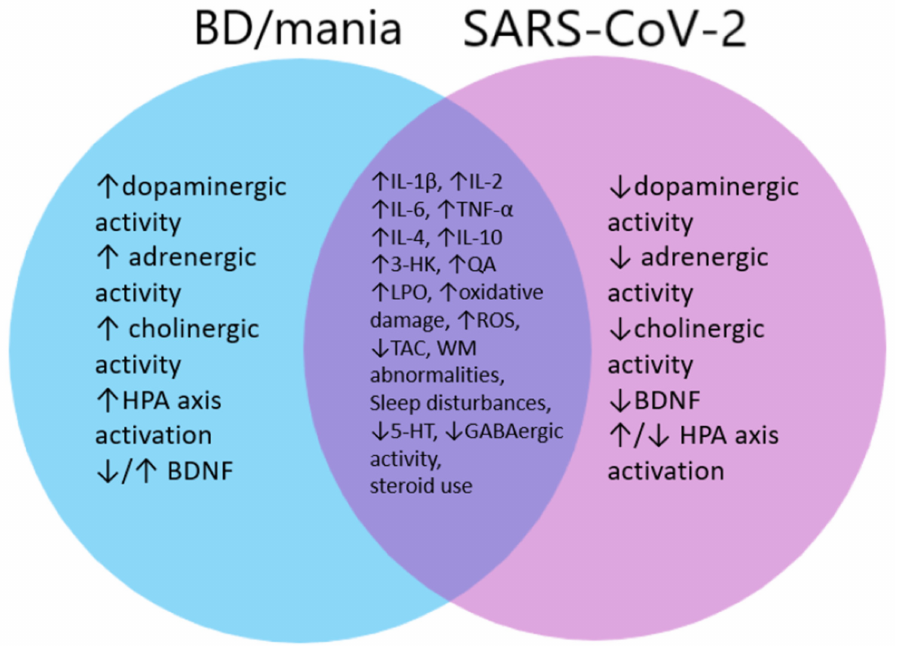
Figure 1. Convergence of disorders caused by SARS-CoV-2 and factors contributing to the devel- opment and course of BD/mania. Disorders inside the common part of both circles coincide with each other the most. Disorders outside the common part of the circles are different, inconclusive or inconsistent (explained in the main text). Abbreviations: ↑ —increased